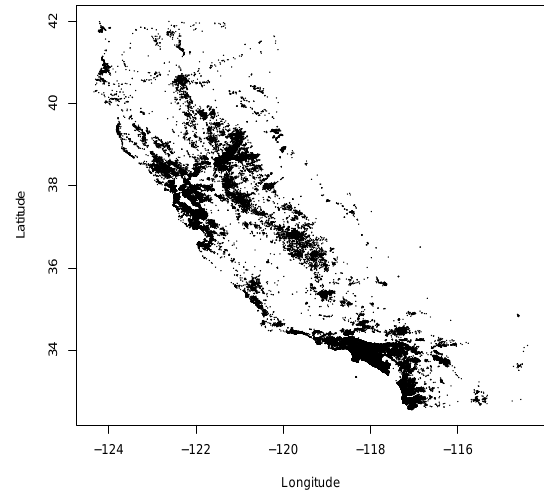
Figure 5. Donors in